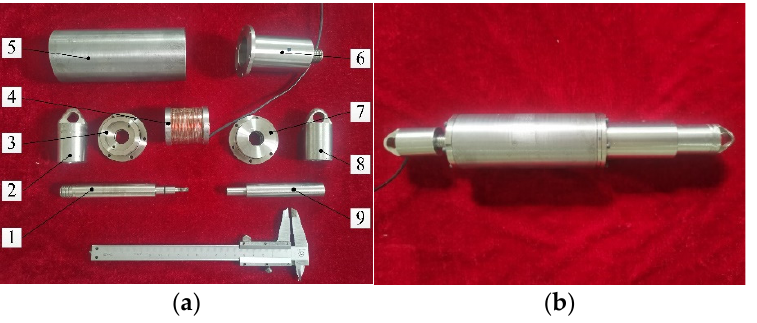
Figure 17. Prototype of MR damper. ( a ) Components: (1) left piston rod, (2) left lifting lug, (3) left end cover, (4) piston head, (5) cylinder, (6) end shield, (7) right end cover, (8) right lifting lug, (9) right piston rod. ( b ) the prototype.